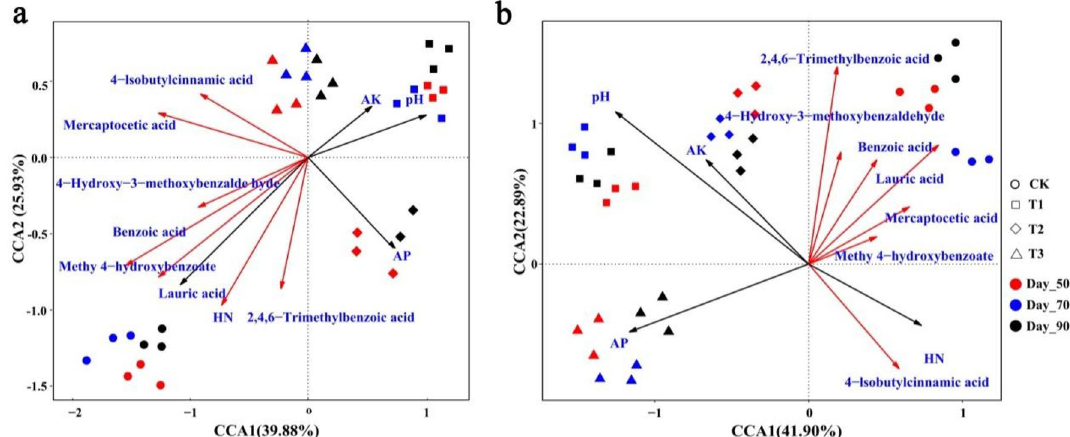
Figure 5. Canonical correspondence analysis (CCA) of the relative abundance of microbial community with soil physicochemical properties and metabolites. (a) Soil bacterial community, (b) soil fungal community. The soil properties and metabolites are indicated with arrows, including soil pH, hydrolysable nitrogen (HN), available phosphorous (AP), available potassium (AK), benzoic acid, lauric acid, 4-hydroxy-3- methoxybenzaldehyde, methyl 4-hydroxybenzoate, 4-Isobutylcinnamic acid, 2,4,6-trimethylbenzoic acid and mercaptoacetic acid. CK: the control group, T1: marigold powder mix with B. amyloliquefaciens ZM9 group, T2: B. amyloliquefaciens ZM9 group, T3: marigold powder. The percentage of variation is explained by each positively correlated with HN, 4-hydroxy-3-methoxybenzaldehyde, benzoic acid, methyl 4-hydroxybenzoate, lauric acid, 2,4,6-trimethylbenzoic acid and mercaptoacetic acid (Fig. 5a). For fungi, the fist canonical axis was